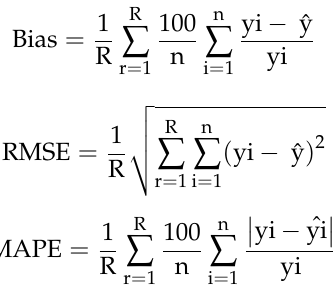
Table 2. Cont. Equation Input Variable No. Model set 2b: Compound predictor variables including D, H, ρ and CV, n = 40